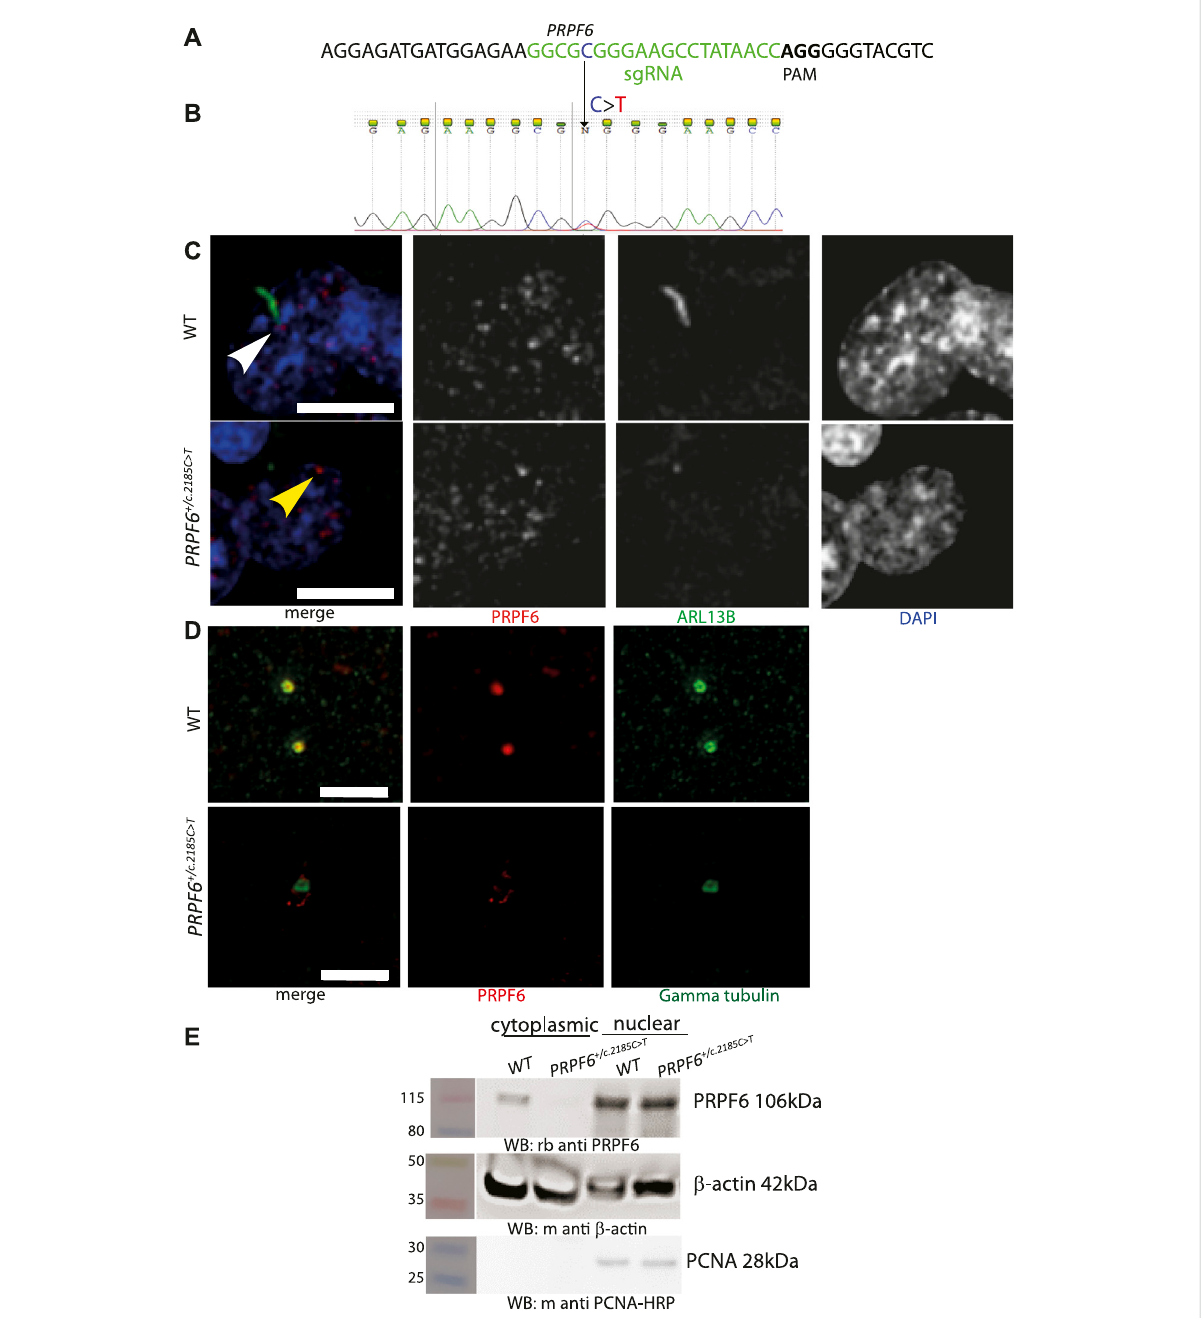
FIGURE 1 Generation and characterisation of PRPF6 +/c.2185C > T base edited HEK293 cells. (A) Illustration of location and sequence of PRPF6 guide RNA in green, with PAM sequencing in bold. (B) Electropherogram of PRPF6 sequence from of PRPF6 +/c.2185C > T base edited HEK293 cells to con fi rm the heterozygous change. (C) Confocal microscopy images of WT and PRPF6 +/c.2185C > T base edited HEK293 cells immunostained with anti PRPF6 (red) and ARL13B (green) antibodies, showing the ARL13B-stained cilium in wild-type (WT) cells (white arrowhead), lost in PRPF6 +/c.2185C > T cells, and the loss of PRPF6 from the base of the cilium (yellow arrowhead). Scale bar 10 μ m. (D) Stimulated emission depletion (STED) microscopy images of wild-type (WT) and PRPF6 +/c.2185C > T base edited HEK293 cells immunostained with anti PRPF6 (red) and gamma tubulin (green) antibodies, showing colocalizationofPRPF6withthegammatubulin-stainedbasalbodyinWTcellsandlossofthiscolocalisationin PRPF6 +/c.2185C > T cells.Scalebar2 μ m. (E) Western blot image showing presence of PRPF6 protein in the nucleus of WT and PRPF6 +/c.2185C > T cells, but absence of PRPF6 protein from the cytoplasm of PRPF6 +/c.2185C > T cells, beta actin is shown as a cytoplasmic loading control, and PCNA is shown as a nuclear loading